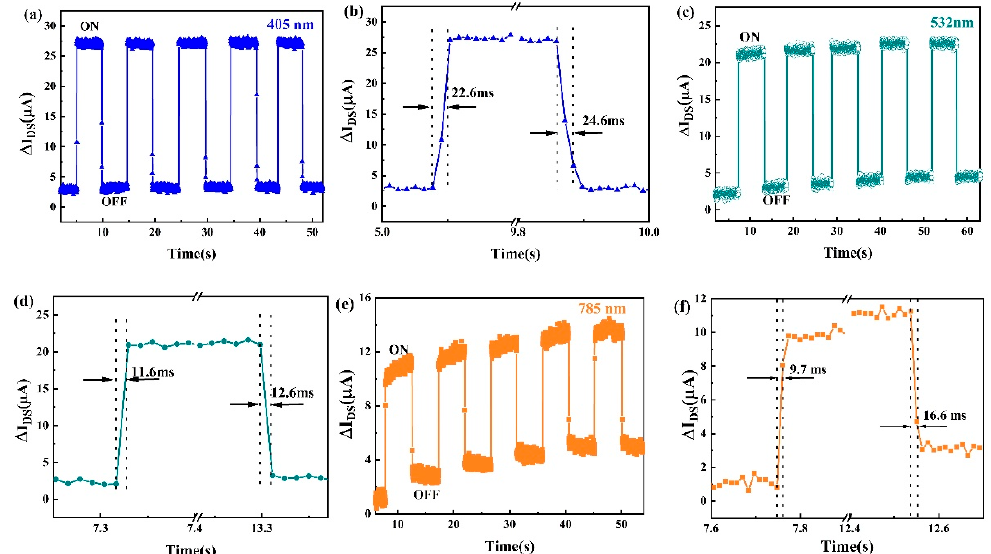
Figure 7. Channel photocurrent response to on/off light illumination ( a ) 405 nm ( c ) 532 nm ( e ) 785 nm for several cycles and time-resolved channel photocurrents to show the rise and fall times for ( b ) 405 nm ( d ) 532 nm ( f ) 785 nm. (Light power density of 155.2 μ W/cm 2 , V G = 0 V, and V DS = 0.05 V).